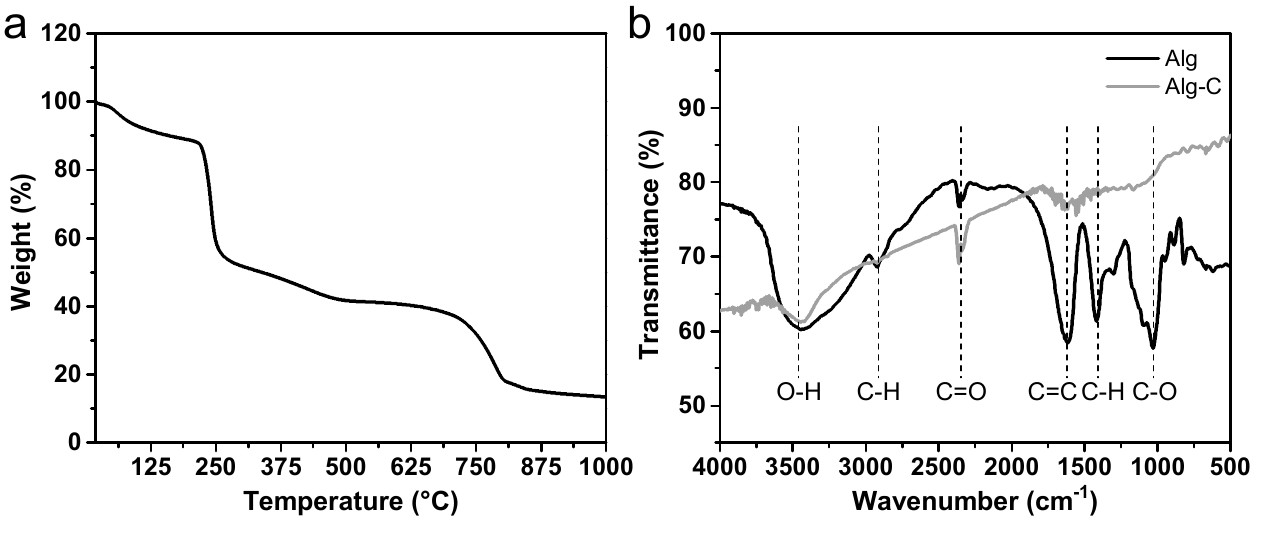
Figure 2. ( a ) TGA curve of Na-alginate biopolymer obtained from brown algae. ( b ) FTIR spectra of Na-alginate and its derived carbonaceous Alg-C material.